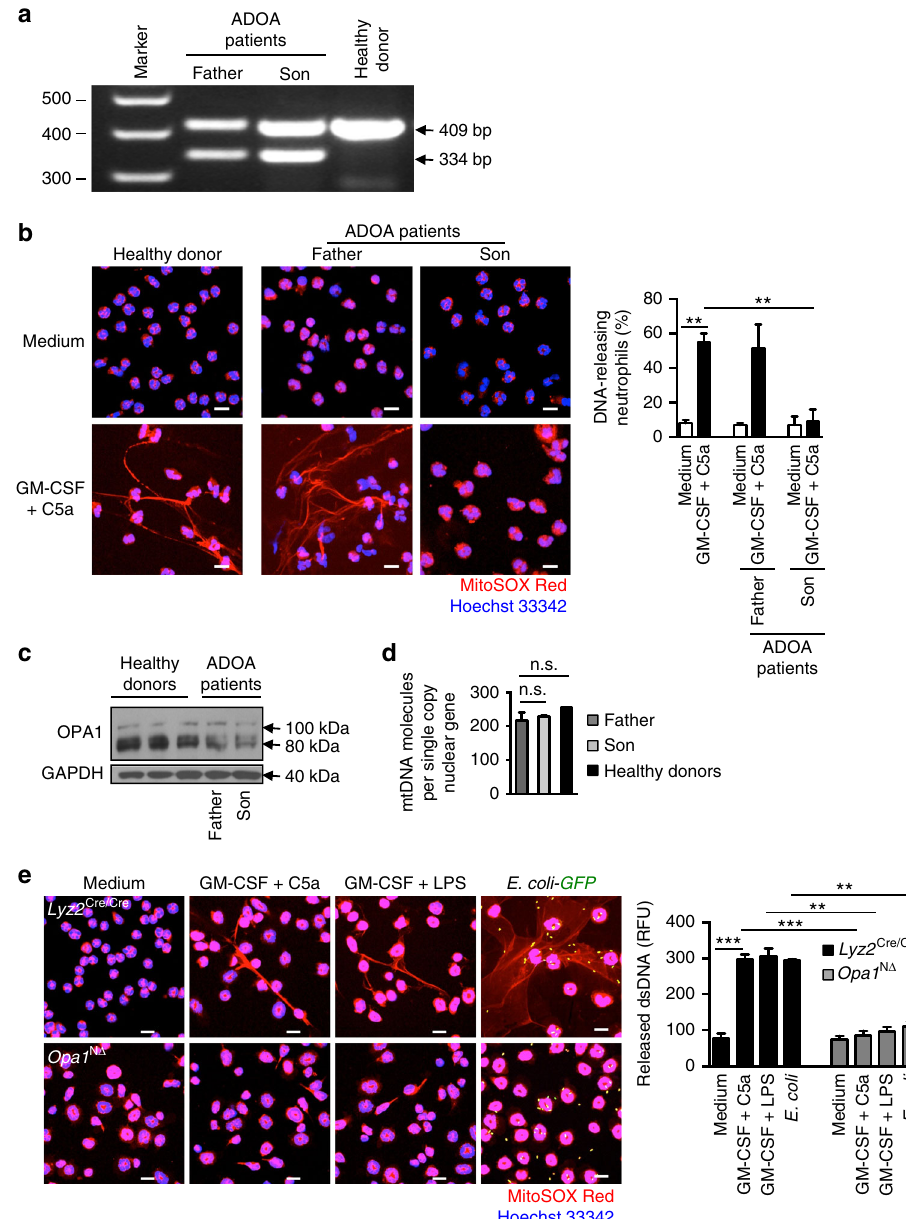
Fig. 1 Failure of DNA release by OPA1-de fi cient human and mouse neutrophils. a Molecular characterization of OPA1 transcripts in ADOA patients. OPA1 transcript analysis from isolated neutrophils encompassing exons 10 – 12 derived from a control and two ADOA patients harboring the